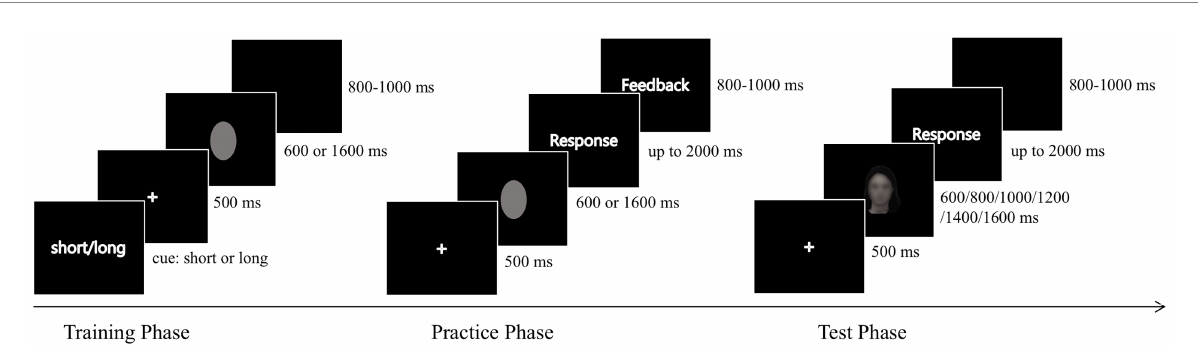
FIGURE 2 Schematic flow of the experiment. In the training phase, a 500 ms fixation followed a cue indicating the short or long standard duration (presented as a gray ellipse) that would appear subsequently. A blank screen presented at a random time between 800 and 1,000 ms before the next trial. In the practice phase, a gray ellipse presented for either 600 or 1,600 ms appeared after a 500 ms fixation. The participants were required to classify the duration of the ellipse into a short or long standard interval. Thereafter, feedback was presented for 800–1,000 ms. In the test phase, the face pictures replaced the gray ellipse and were presented as probe durations. A blank screen replaced the feedback in this